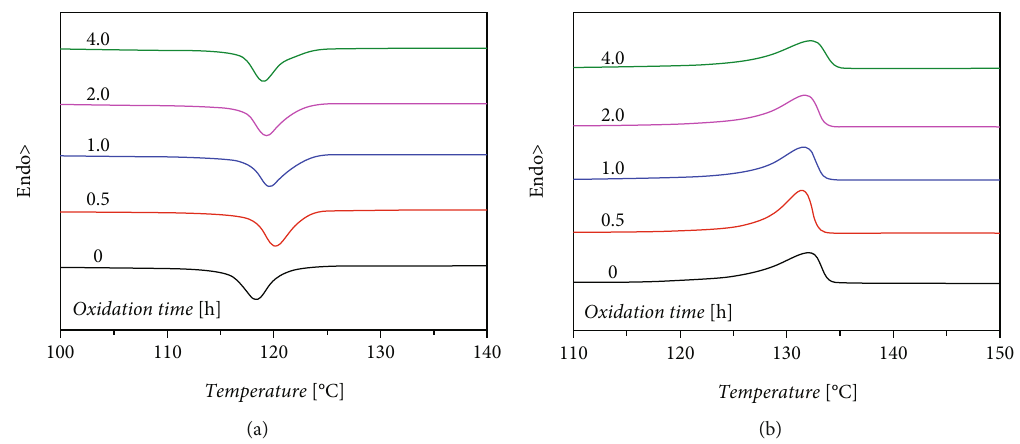
Figure 7: The DSC curves of GNP/oxidized UHMWPE composites. Table 3: The DSC data of GNP/oxidized UHMWPE composites. Oxidation time